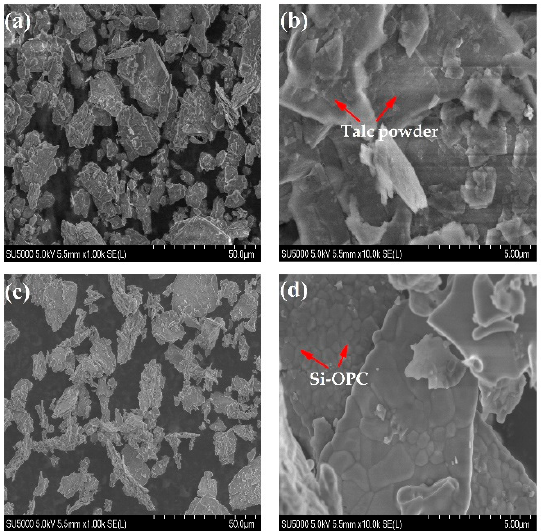
Figure 5. SEM images of talc powder (( a ), 1.00 k; ( b ), 10.0 k) and Si-OPC fertilizer (( c ), 1.00 k; ( d ), 10.0 k).